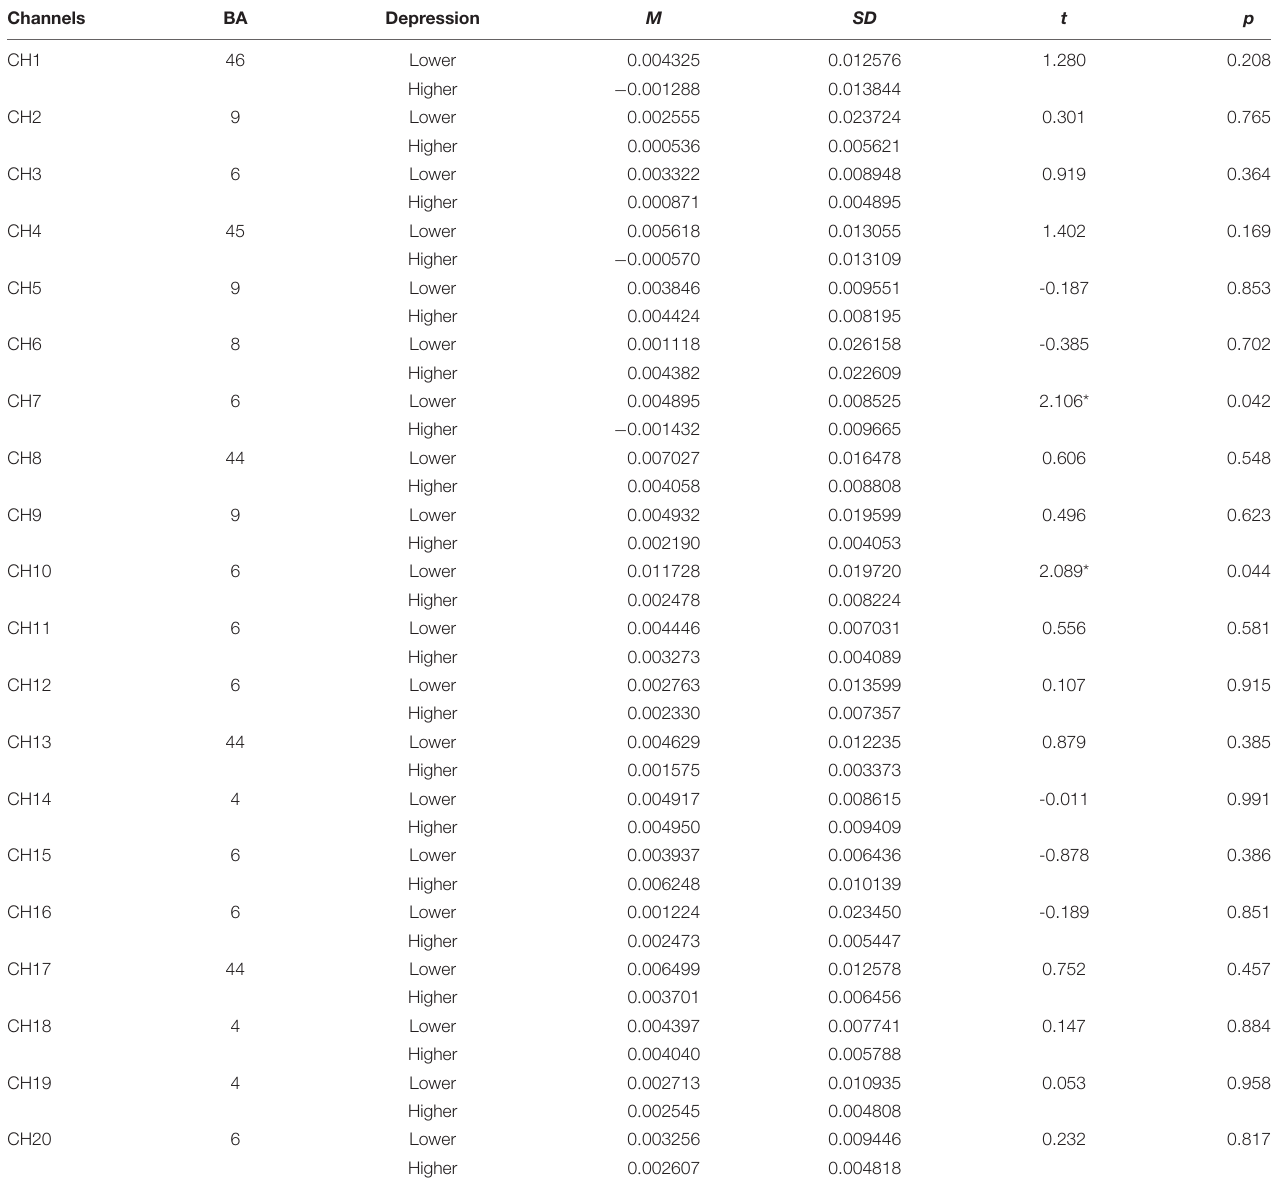
TABLE 6 | The comparison of brain activation between higher and lower groups in rotation stage for subject mirrored images (HbO). Channels BA Depression